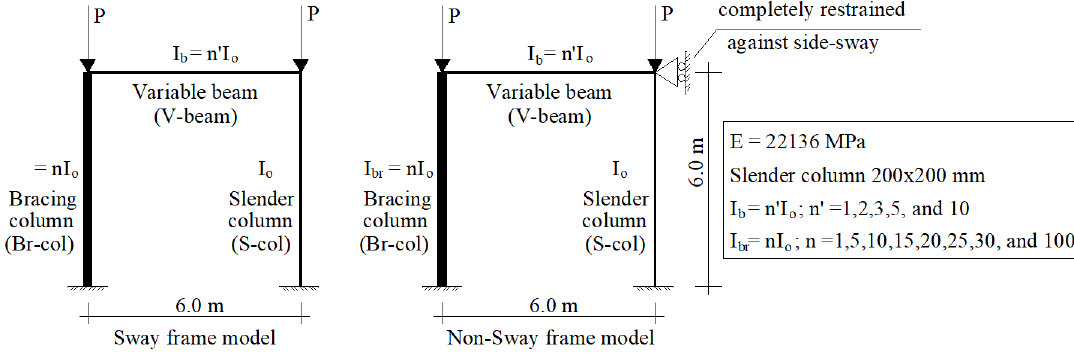
Figure 2. One-story, one bay-frame model.